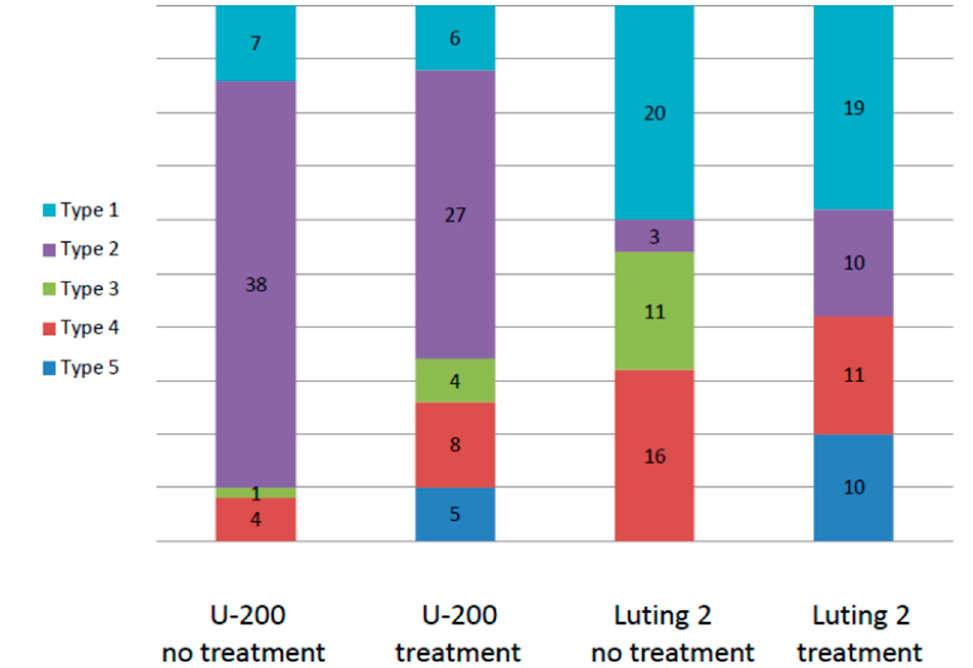
Figure 1. Distribution of failure modes (number of surfaces) for each cementation group: Type 1—Adhesive cement-dentin; Type 2—Adhesive cement-crown; Type 3—Cohesive cement; Type 4—Mixed mode; Type 5—Cohesive dentin.